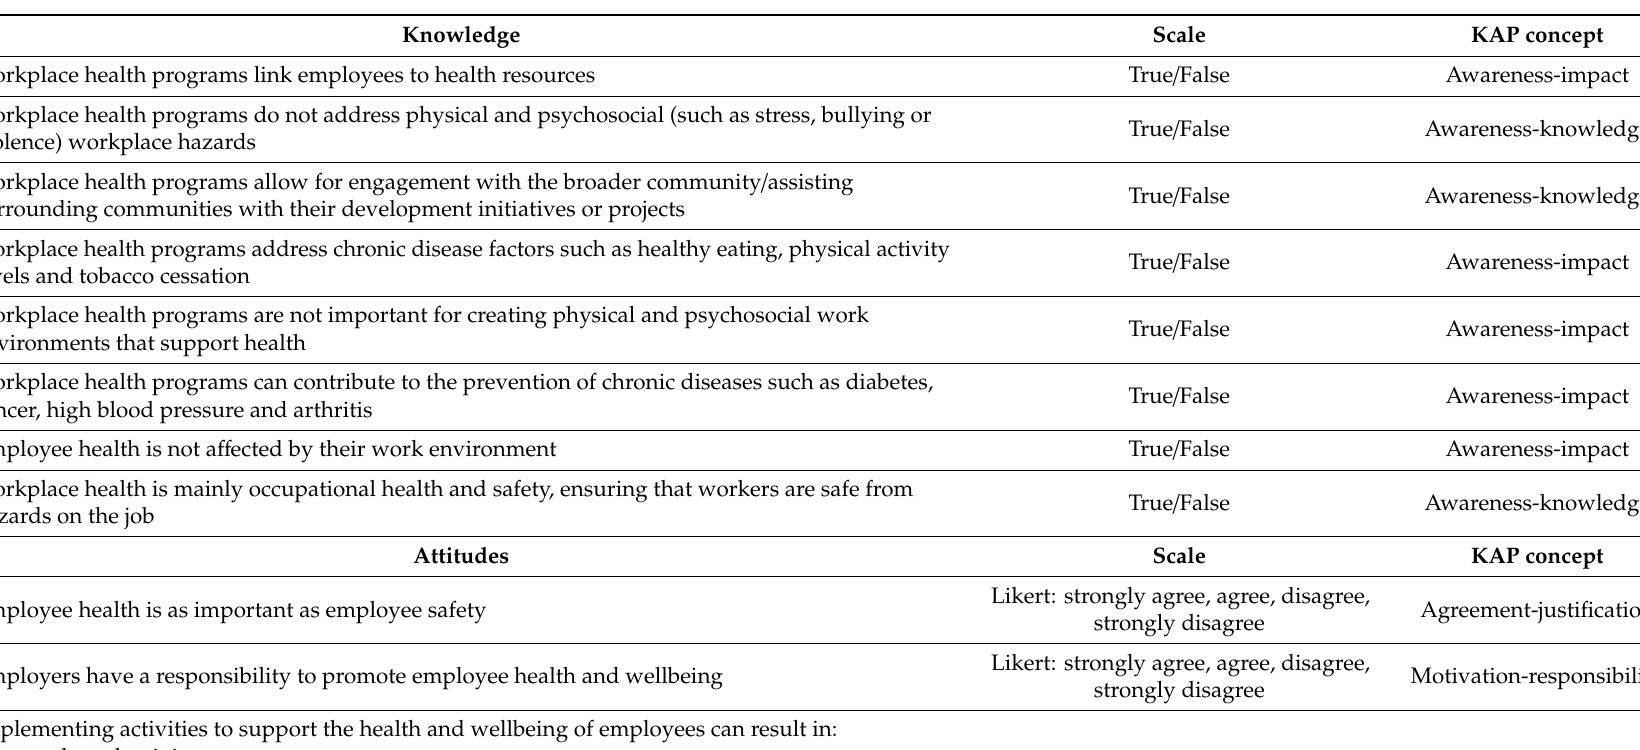
Table A1. Workplace Health KAP Survey Instrument Including Question Scale and KAP Concepts from Conceptual